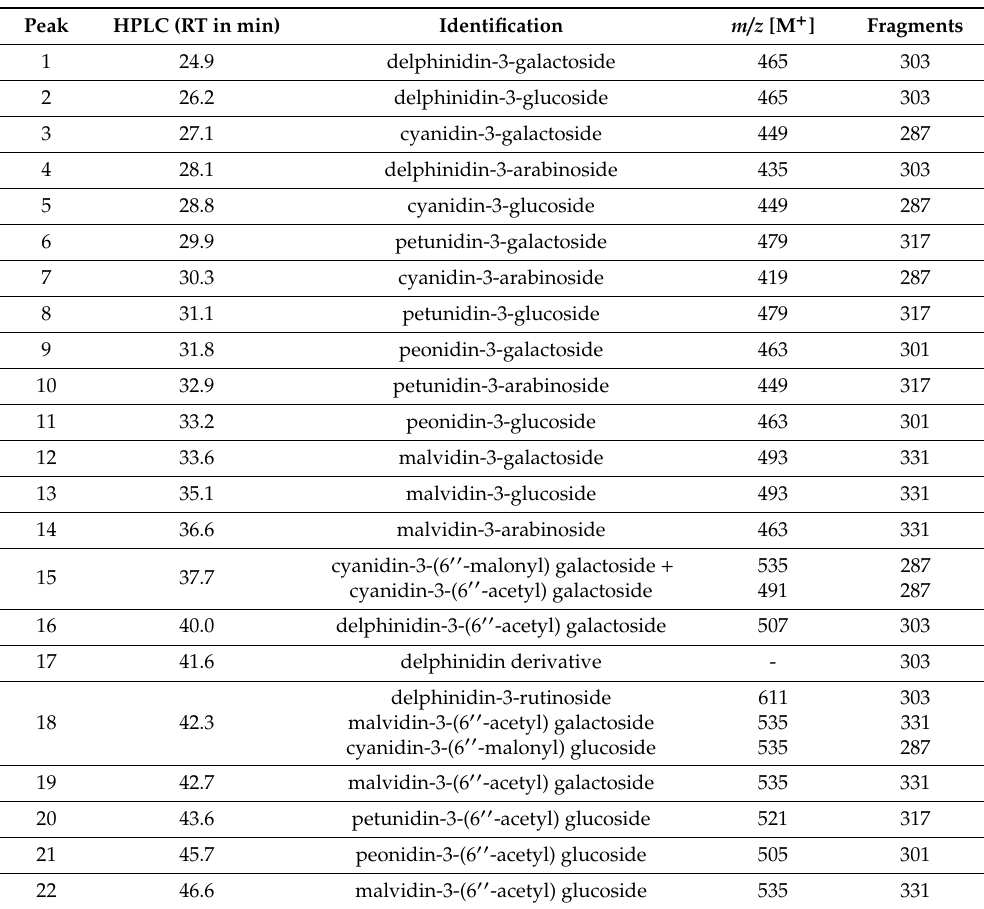
Table 1. Peak assignments, retention times (RT in min), and mass spectral data of anthocyanins in extract from WBB